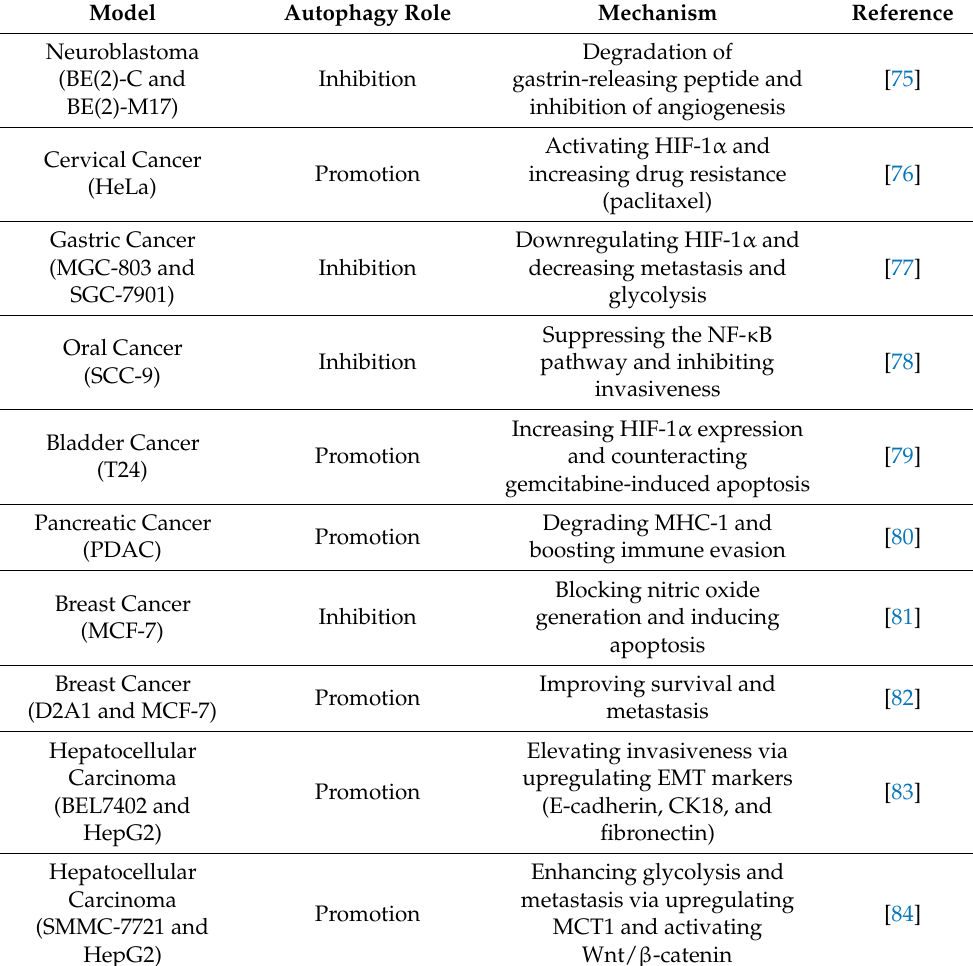
Table 1. Dual role of autophagy in tumor promotion and